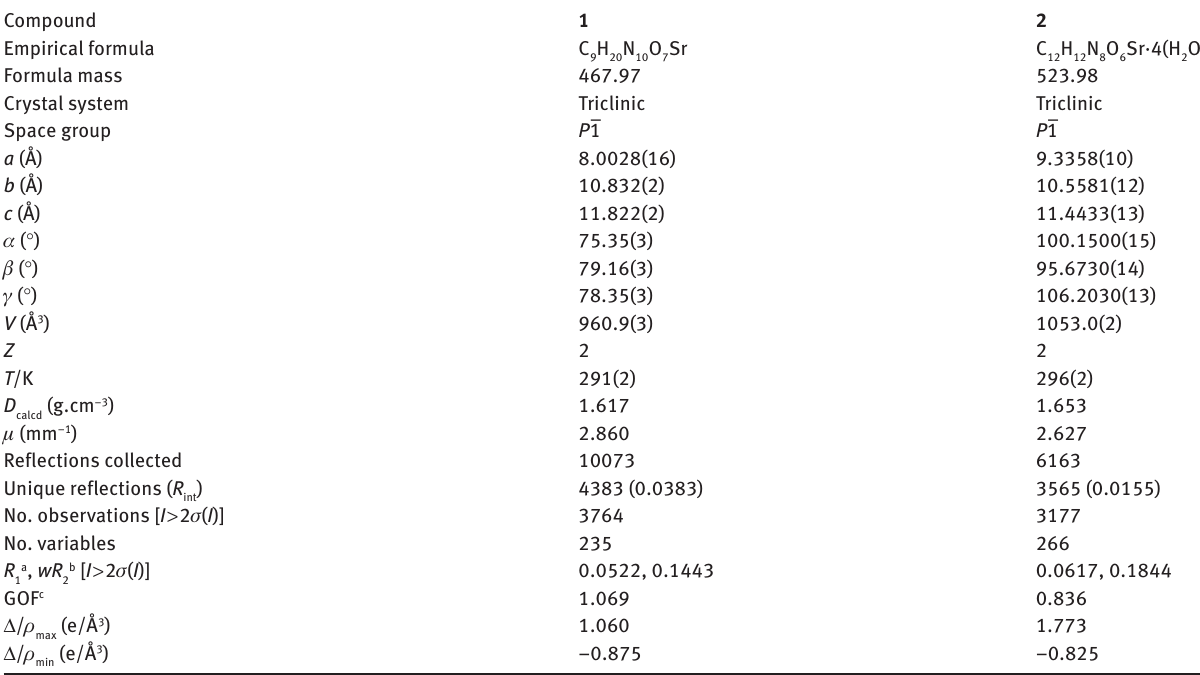
Table 1: Selected crystallographic data and structure refinement for 1–2